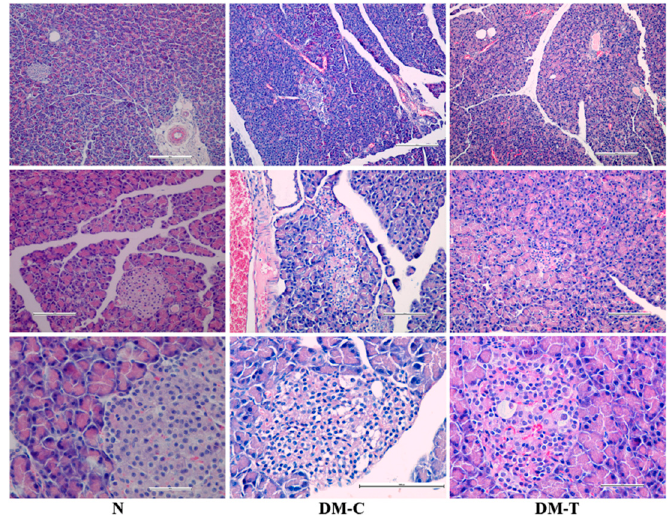
Figure 3. Histopathologic examination of pancreas in N, DM ‐ C, and DM ‐ T rats.